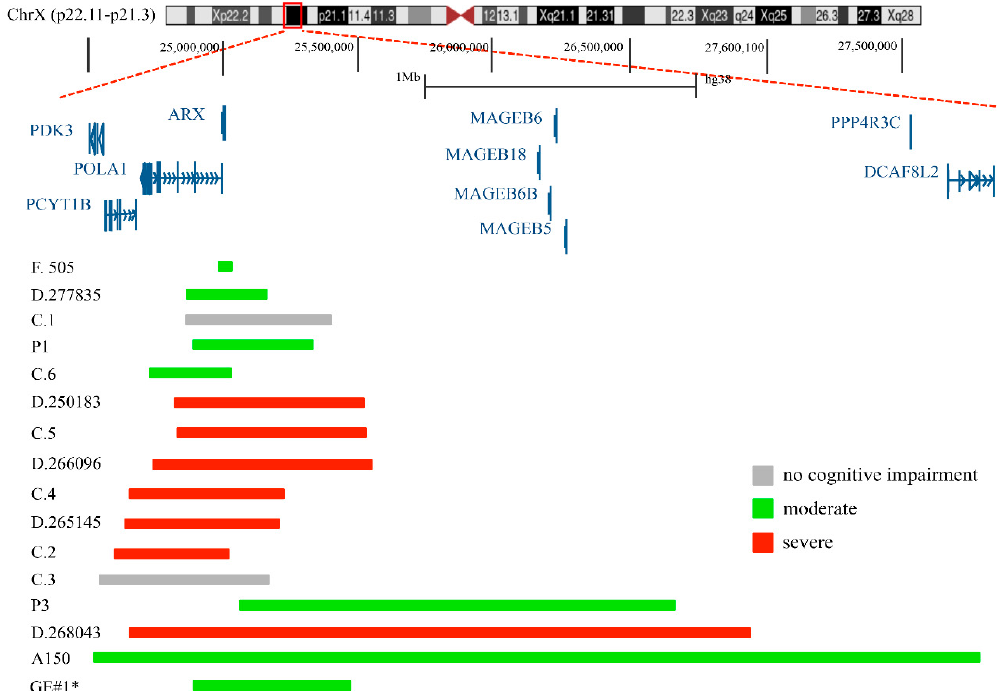
Figure 1. Genomic mapping of duplications encompassing the ARX locus. Of them, 15 have already been described in the literature, and one, GE#1*, is described in this report for the first time. Popovici et al. [21] reports on four duplications of Xp21.3. Two of them, a 440 Kb and a 580 Kb duplication, included the full copies of POLA1 and ARX genes and were found in two males with syndromic ID (case 2 and case 4; Table 1); meanwhile, the remaining two—a 540 Kb duplication, which included a full copy of the ARX gene, and a 630 Kb duplication, which included full copies of Phosphate cytidyltransferase 1 choline beta isoform ( PCYT1B ; MIM 300948), POLA1 and ARX —were found in two males